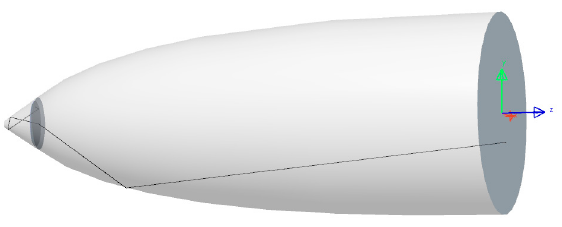
Figure 15. Typical LENS pixel ray path obtained with LightTools software .